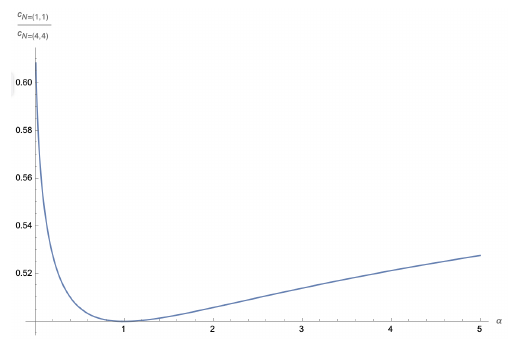
Figure 1. Ratios of central charges for the N = (1 , 1) and N = (4 , 4)